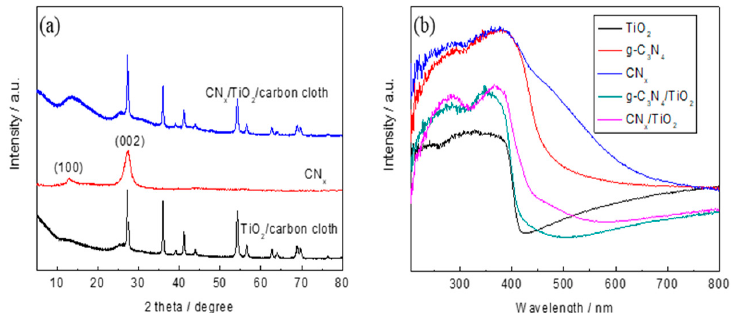
Figure 2. ( a ) XRD patterns of TiO 2 nanowire arrays, CN x , CN x /TiO 2 core-shell nanowire arrays. ( b ) UV-Vis diffuse reflectance absorption of TiO 2 nanowire arrays, g-C 3 N 4 , CN x , g-C 3 N 4 /TiO 2 nanowire arrays and CN x /TiO 2 core-shell nanowire arrays.